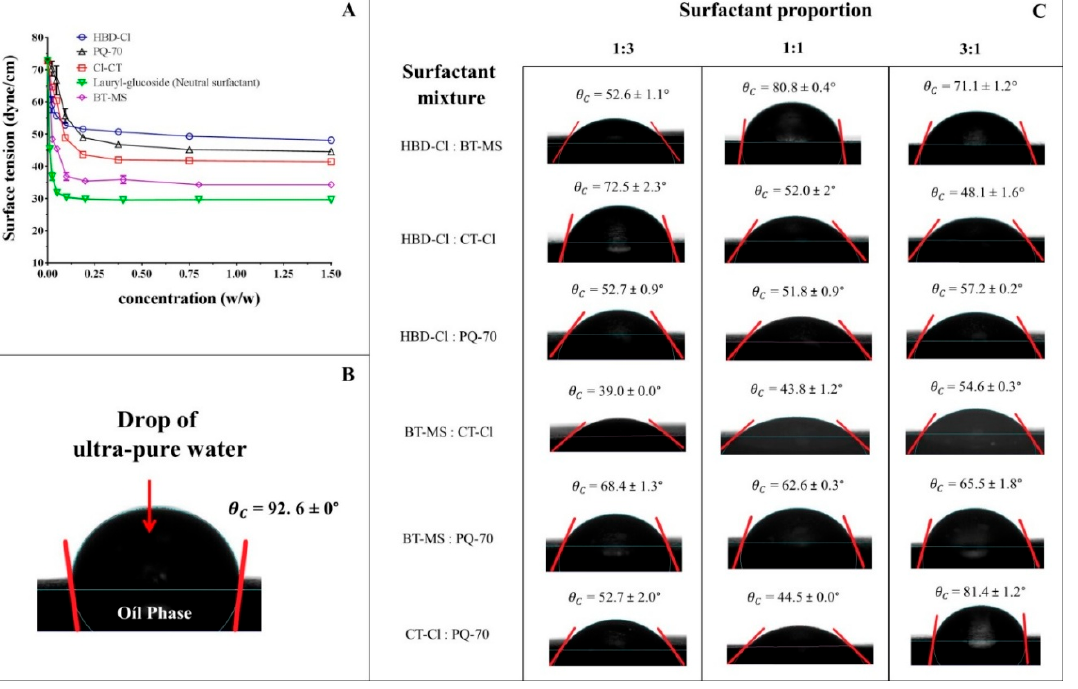
Figure 2. ( A ) The reduced surface tension due to the concentration of surfactants used in the hair conditioner formulation. ( B ) A drop of ultra-pure water lying on top of the oil phase. ( C ) Drops of the cationic surfactant blends in aqueous solution lying on top of the oil phase. HBD-Cl: Hydroxyethyl-behenamidopropyl-diammonium chloride, BT-MS: Behentrimonium methosulphate, CT-Cl: Cetrimonium chloride, and PQ-70: Polyquaternium-70.